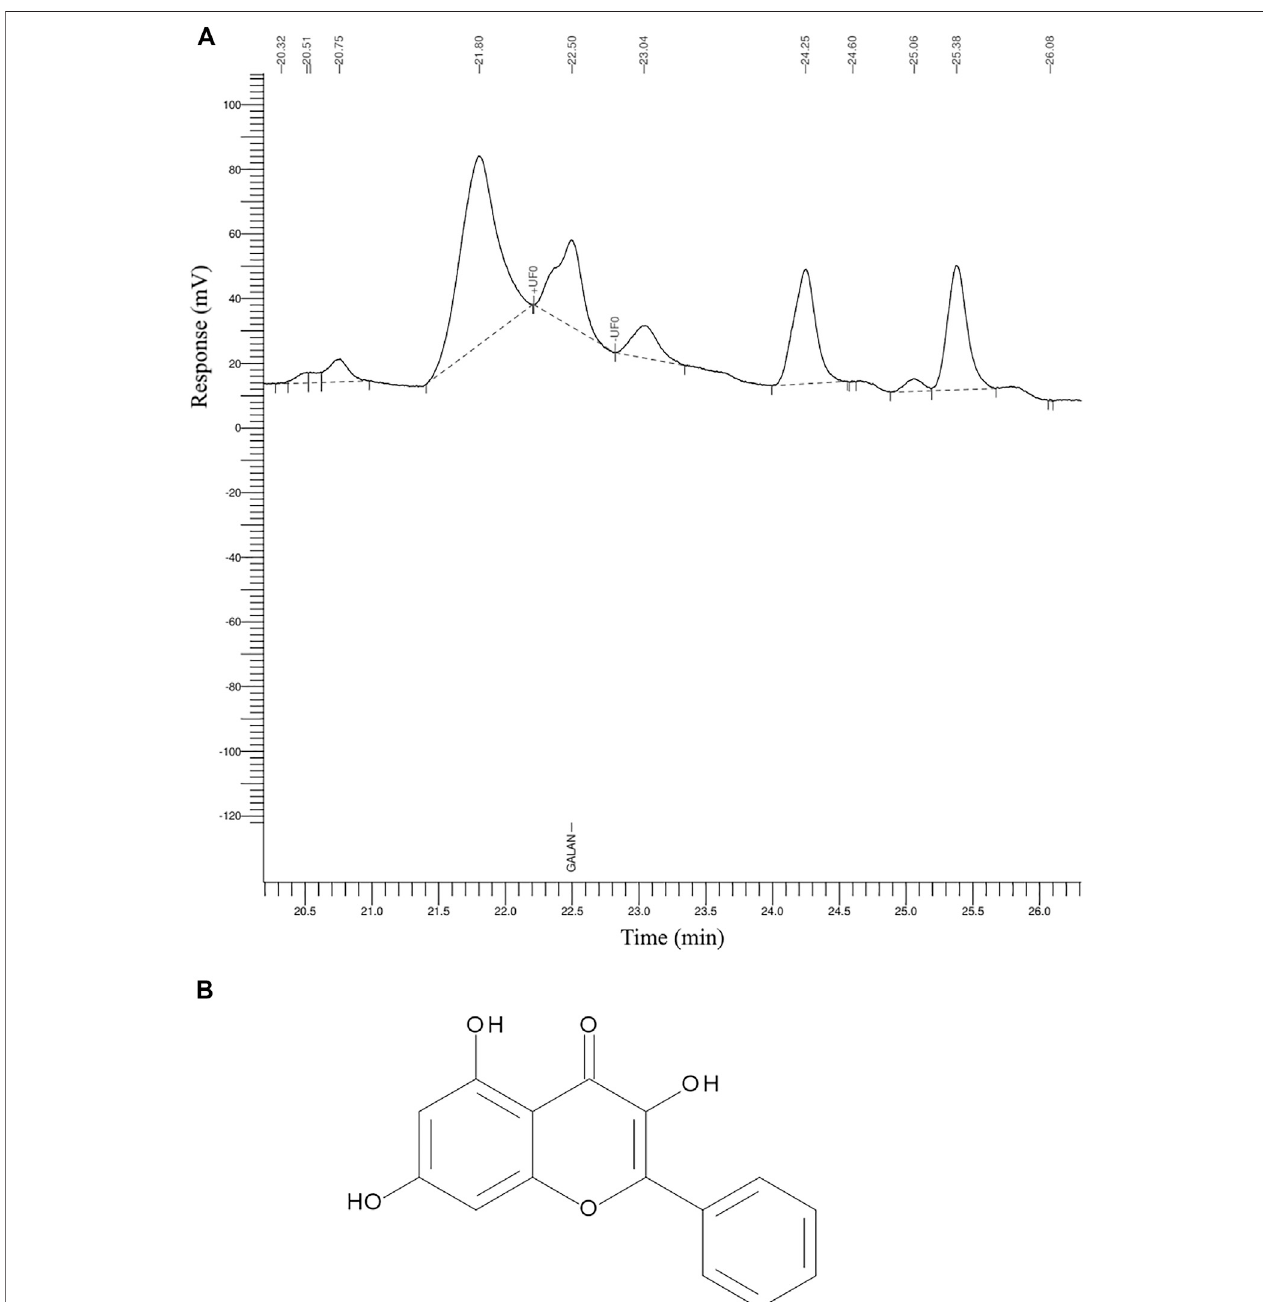
FIGURE 2 | The HPLC chromatogram of (A) G. radlkoferi EtOH leaf extract used for the quanti fi cation of (B) galangin.